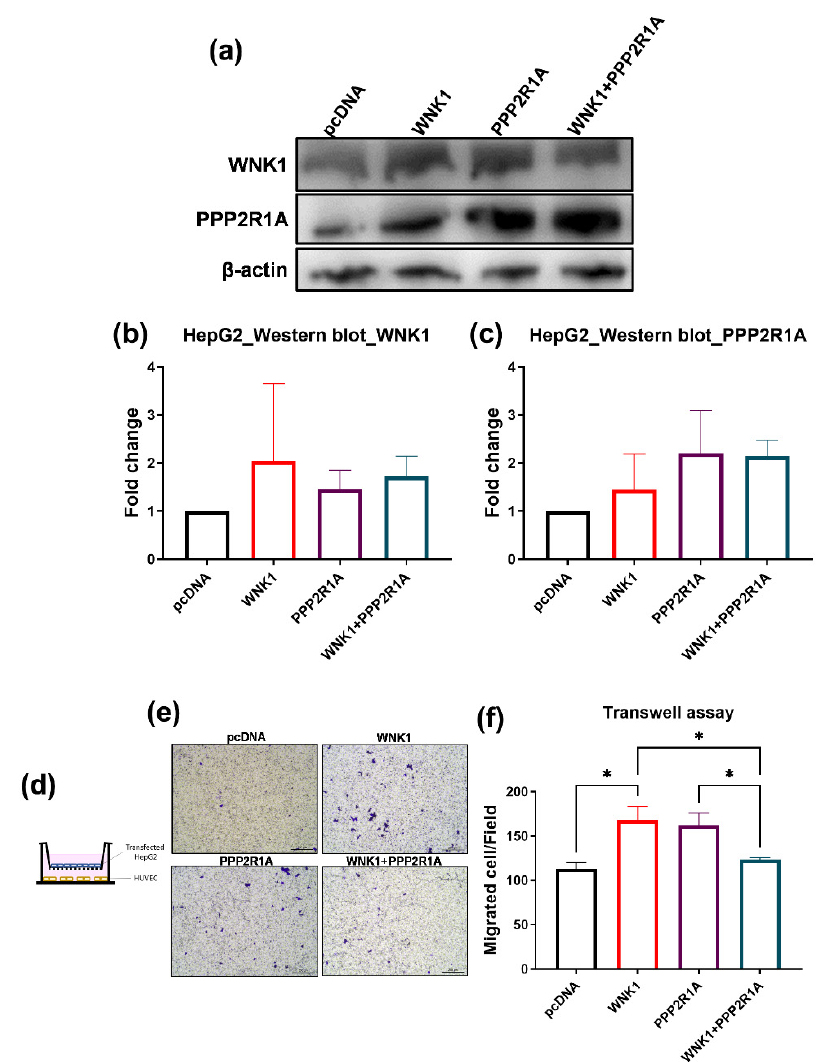
Figure 10. Overexpression of WNK1 in HepG2 cells significantly increases the migrated cells, and the co-expression of PPP2R1A can decrease the migrated cells caused by WNK1 overexpression in hepatoma cells. ( a ) The protein levels of WNK1 and PPP2R1A were examined by Western blot. ( b ) Western blot indicates that overexpression of WNK1 in HepG2 cells significantly increases the WNK1 protein levels. ( c ) Overexpression of PPP2R1A in HepG2 cells significantly increases the PPP2R1A protein levels. ( d ) The modulated expression of WNK1 and PPP2R1A in HepG2 hepatoma cells that were seeded in the upper chamber while HUVEC cells were loaded in the lower chamber of the transwell plate. ( e ) Representative images of hepatoma cell migration. The scale bar is 200 µ m in length. ( f ) Quantified data of the transwell migration assay reveal that overexpression of WNK1 in HepG2 cells significantly increases the migrated cells, indicating that WNK1 plays an important role in hepatoma cells for stimulating hepatoma cell migration. Overexpression of PPP2R1A in HepG2 cells can revert the increased migrated cells caused by WNK1, indicating that PPP2R1A is a downstream effector for hepatoma cell migration. We performed three replicates for each Western blot and transwell analysis. One-way ANOVA analysis followed by multiple analysis of variance was used to identify the statistical significance between groups. *: p (cid:53)